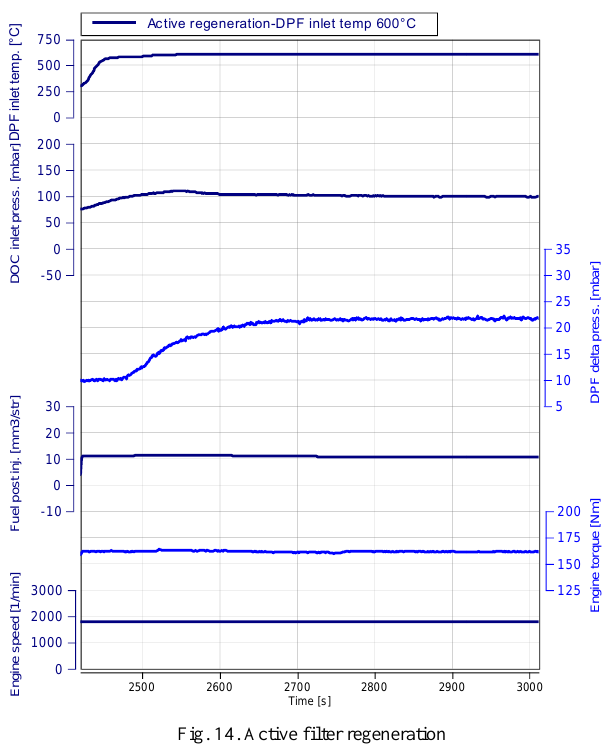
Fig. 14. Active filter